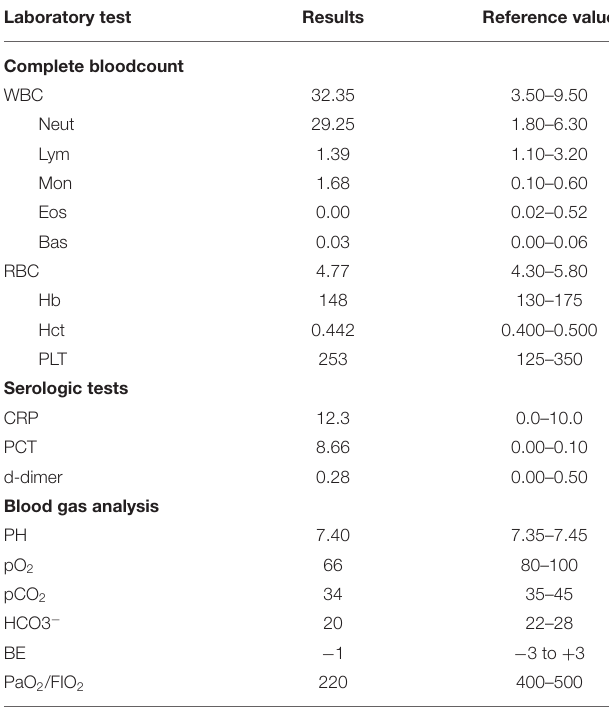
TABLE 1 | Laboratory data of the patient after